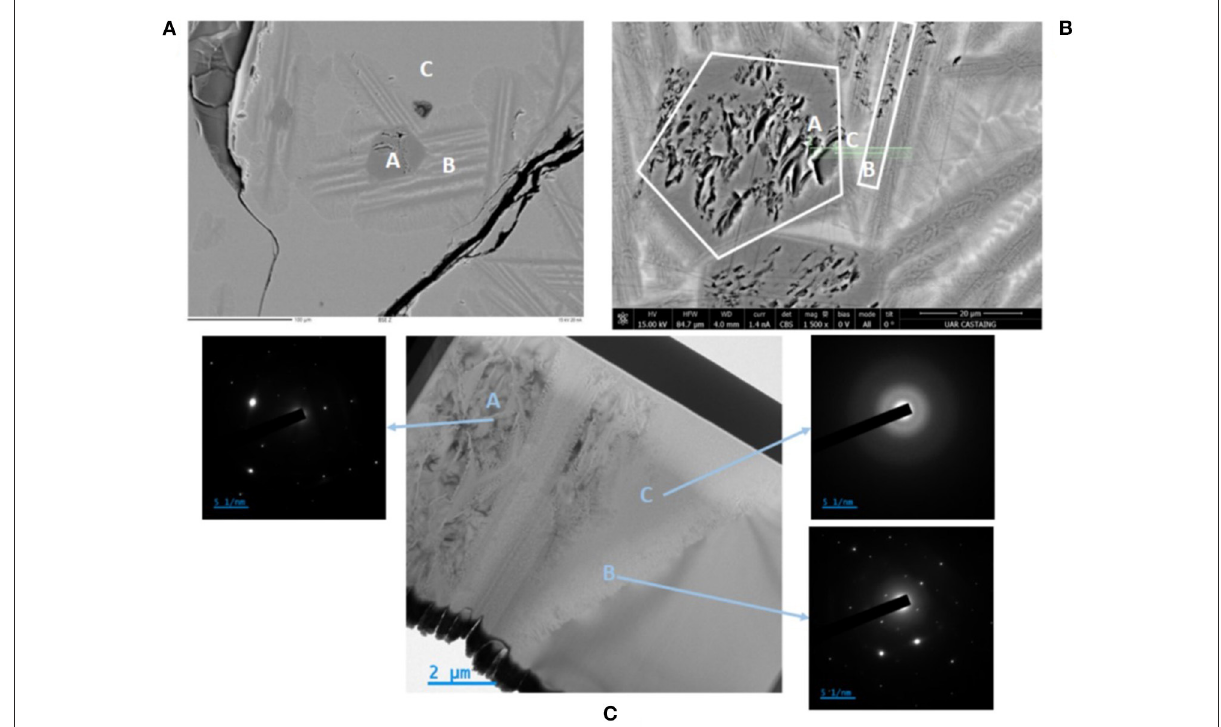
FIGURE2 Micrographs of native ferronickel slag cross-sections: (A,B) SEM observations showing FIB cut on (B) (green line), (C) TEM observation of the FIB lamella with diffraction diagrams— (A) ferrous olivine, (B) sticklike mixture of olivine and enstatite, (C) silicium and aluminum-rich amorphous phase.